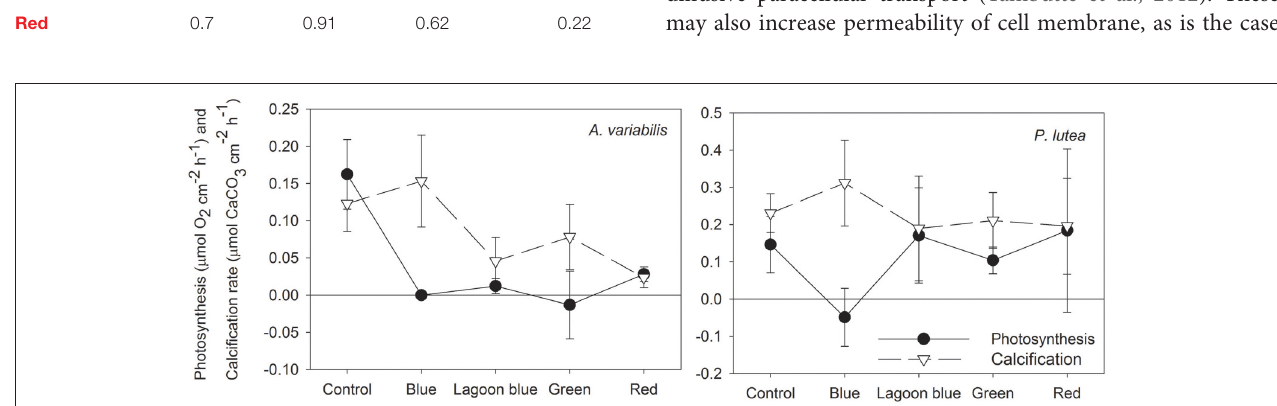
FIGURE 5 | Calcification and photosynthesis of A. variabilis and P. lutea illuminated with 400 µ mol photons m − 2 s − 1 of full spectrum, blue, “lagoon” blue, green, or red light.